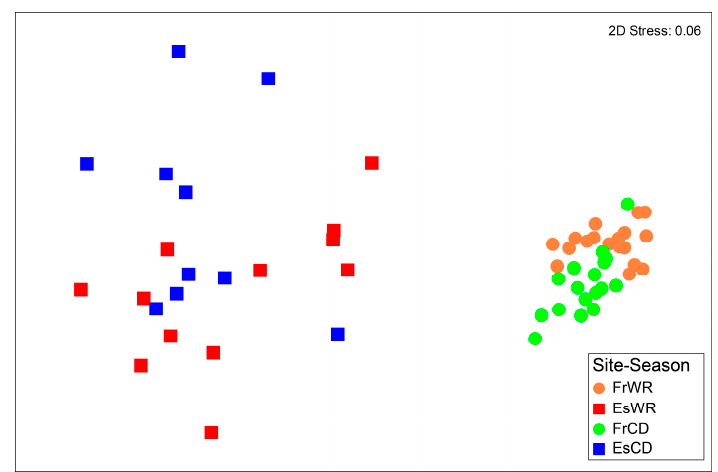
Figure 6. Non-metric multidimensional scaling (nMDS) for fish assemblages from the two study sites during cold-dry and warm-rainy seasons in the lower Nakdong River, South Korea.; Fr = Freshwater, Es = Estuary; WR = warm-rainy season, CD = cold-dry season.